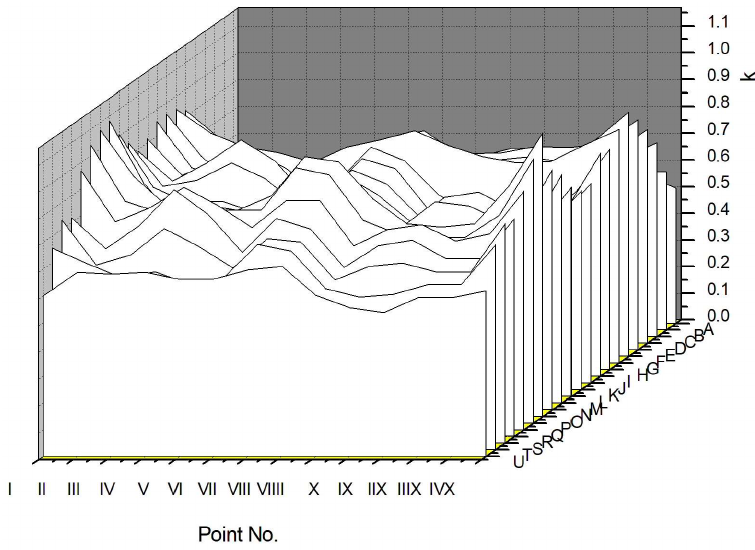
Figure 9. Profile of k in the dark field for red thin-film.